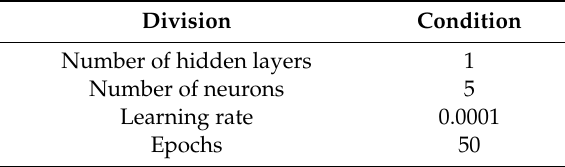
Table 1. Structural and learning parameters for ANN models.